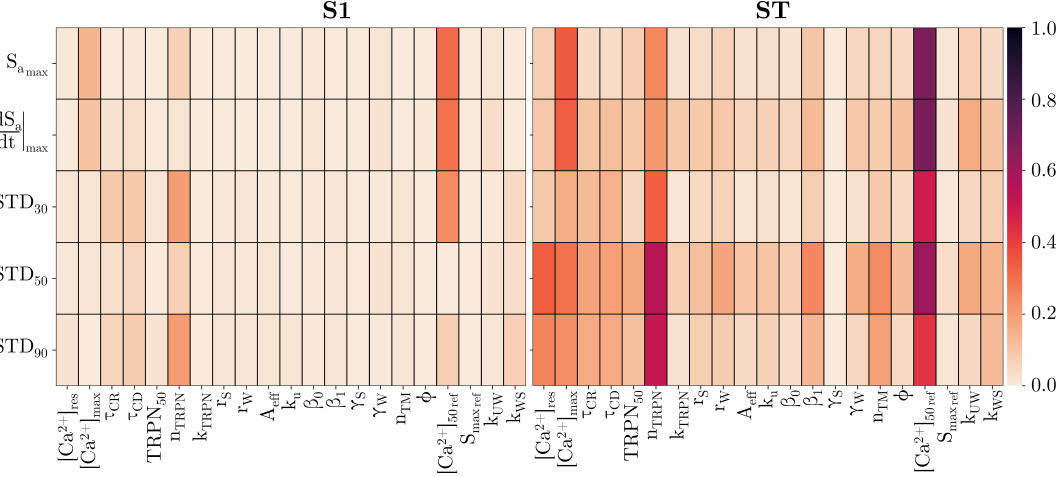
Figure 3. Global sensitivity of active stress biomarkers to parameters of the Land and the Rice model in the 0D EM model. The Sobol global sensitivity analysis was performed and first-order ( S 1) and total-order sensitivity indices ( ST ) are